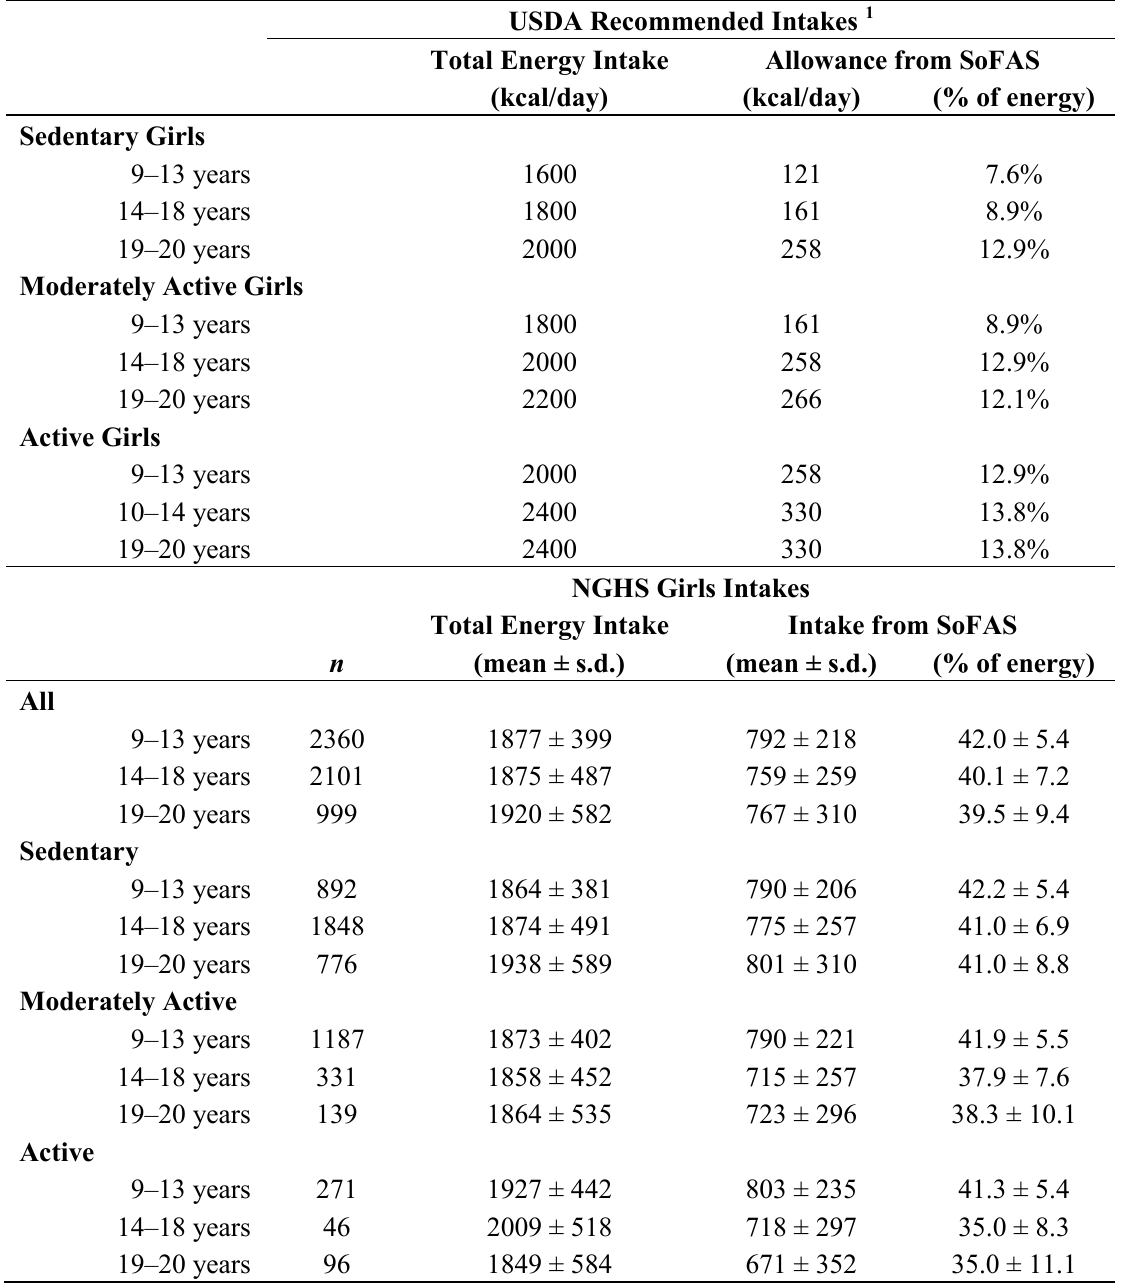
Table 3. USDA recommended energy and SoFAS intakes compared to NGHS girls, stratifying by activity